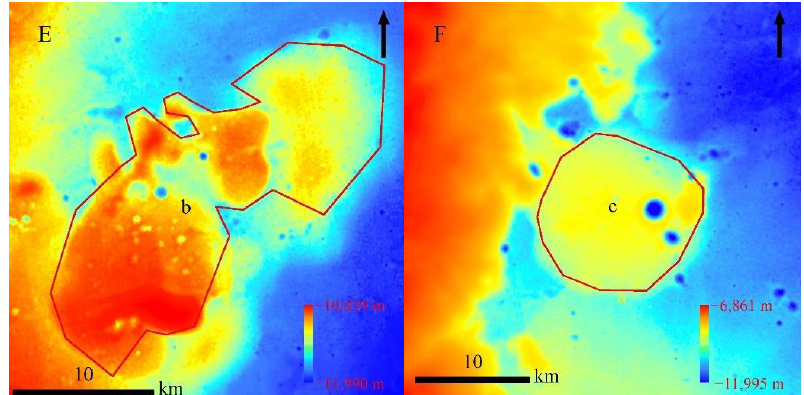
Figure 2. Three basalt measurement areas mapped by red polygons in Von Kármán crater. ( A ) CE-2 DOM mosaic (central location: 175.6° E, 44.64° S) of the Von Kármán crater with CE-4 landing site labeled. The fresh crater pointed by the white arrow is Zhinyu crater. ( B ) Local topography shown in SLDEM; the elevation ranges from − 13,413 m to − 421 m as coded from blue to red in this figure. ( C ) FeO content map [24] in Von Kármán crater; the values range from 0 to 24.73% as coded from blue to red in this figure. ( D ) Basalt unit ‘a’ shown in CE-2 DOM mosaic, with the white arrows indicating the chained secondaries. The area is 138 km 2 . ( E ) Basalt unit ‘b’ is located in a topographical elevated terrain, and the elevation ranges from − 11,990 m to − 10,839 m as coded from blue to red in this figure. The area is 267 km 2 . ( F ) Basalt unit ‘c’ is located in a topographical elevated terrain, and the elevation ranges from − 11,995 m to − 6861 m as coded from blue to red in this figure. The red polygon in each sub-figure is the outlined representative crater count area. The area is 151 km 2 . North is up in all sub-figures.